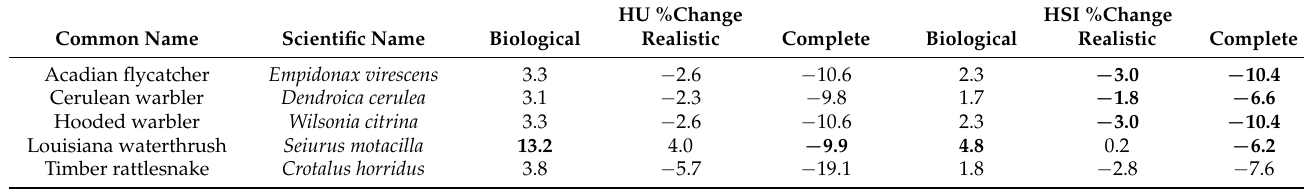
Table 2. Habitat Unit (HU) and Habitat Suitability Index (HSI) percent change estimates from 2020 to 2030 on a statewide basis for five Minnesota threatened, endangered, and special concern species from the three harvest/growth simulation scenarios on Minnesota Department of Natural Resources lands. Values in bold indicant statistical significance at a 0.05 significance level. Caution should be taken in interpreting results for the biological growth and complete harvest scenarios as those scenarios are unlikely to occur in reality and rather serve as upper and lower bounds.